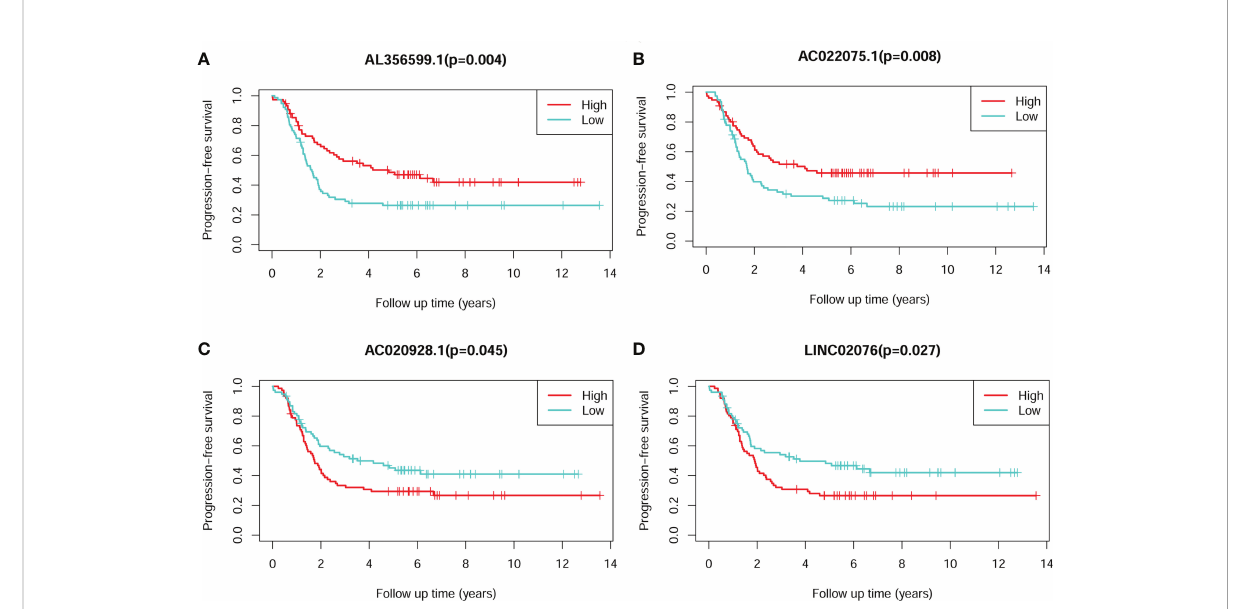
FIGURE 3 The Kaplan-Meier survival plots of the four lncRNAs for PFS of NB patients. (A) AL356599.1. (B) AC022075.1. (C) AC020928.1. (D) LINC02076. The Log-rank tests p-values were shown. PFS, progression-free survival; lncRNA, long noncoding RNA; NB,